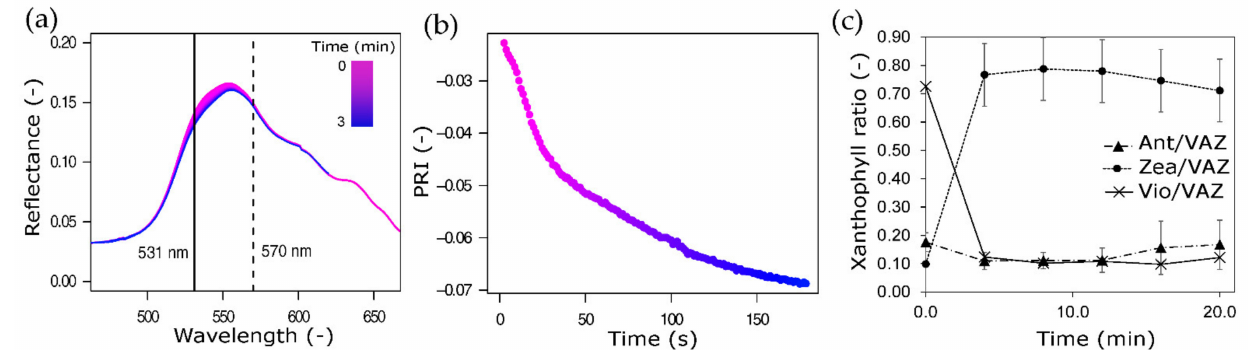
Figure 10. ( a ) The calculated reflectance showing the changes during the first 3 min of the temporal recording of the dark-to-high-light transient (protocol illustrated in Figure 2c); ( b ) the PRI decrease during that range of time; ( c ) the xanthophyll pool changes normalized over the total recorded xanthophyll pool (VAZ) of 3 SU leaves (mean ± SD) sampled every 4 min during the acclimation to saturating light from the LED panel.